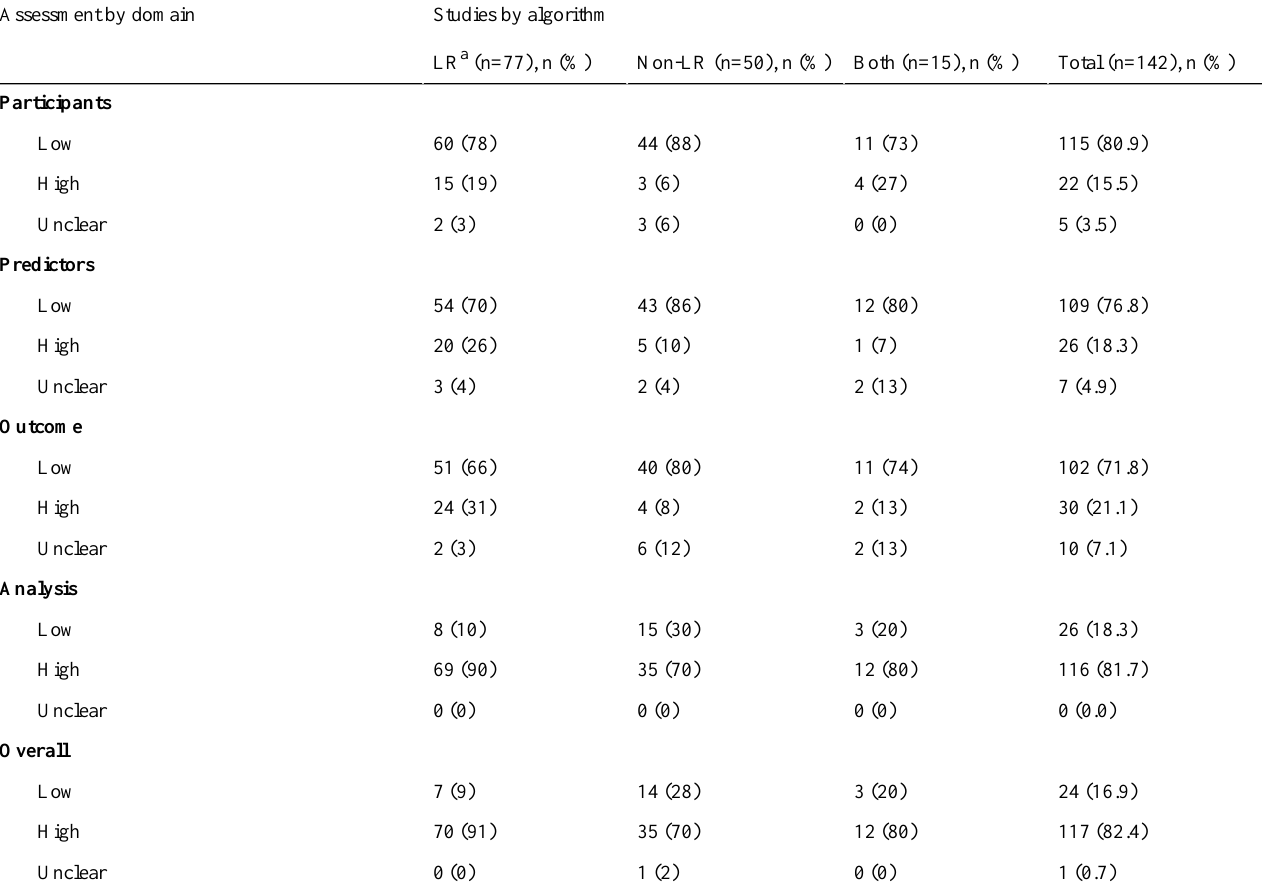
Table 3. Risk of bias within studies.